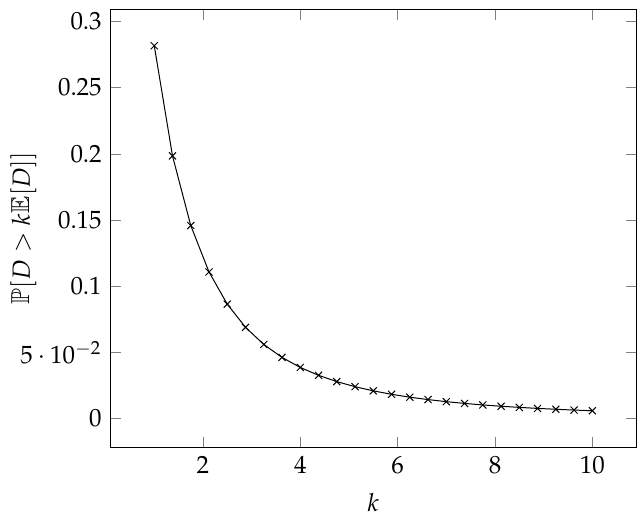
Figure 4. Probability of large